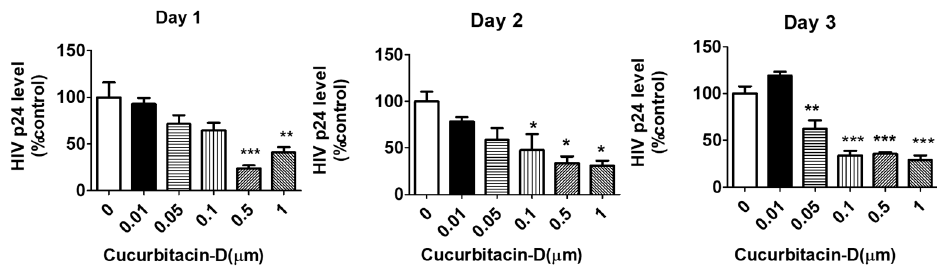
Figure 3. Dose-dependent effect of Cur-D on HIV p24 levels: U1-monocytes were plated in 12-well plates (0.3 million cells/well) and differentiated to macrophages. Differentiated U1 macrophages were treated with different doses of Cur-D ranging from 0.01 – 1 µM for 3 days. The p24 levels were measured every day by the p24 Elisa kit. Viral load was expressed as a percentage of viral load observed in DMSO-treated control wells. The data shown represent the mean ± SEM of three independent experiments. One-way ANOVA with Tukey’s post-hoc test was applied to compare between multiple groups. *, **, and *** represent p < 0.05, p ≤ 0.01, and p ≤ 0.001, respectively, when compared to 0 µ M of